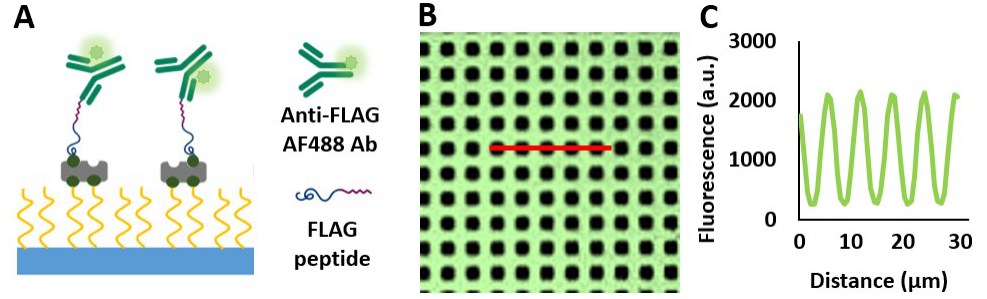
Figure A3. Determination of pattern contrast and biomolecule density on micropatterned substrates using fluorescence microscopy. ( A ) Schematic overview of anti‐FLAG‐AF488 binding to micropatterned FLAG peptide. ( B ) Fluorescence image (image size: 65 × 65 μm) and ( C ) corresponding line profile.